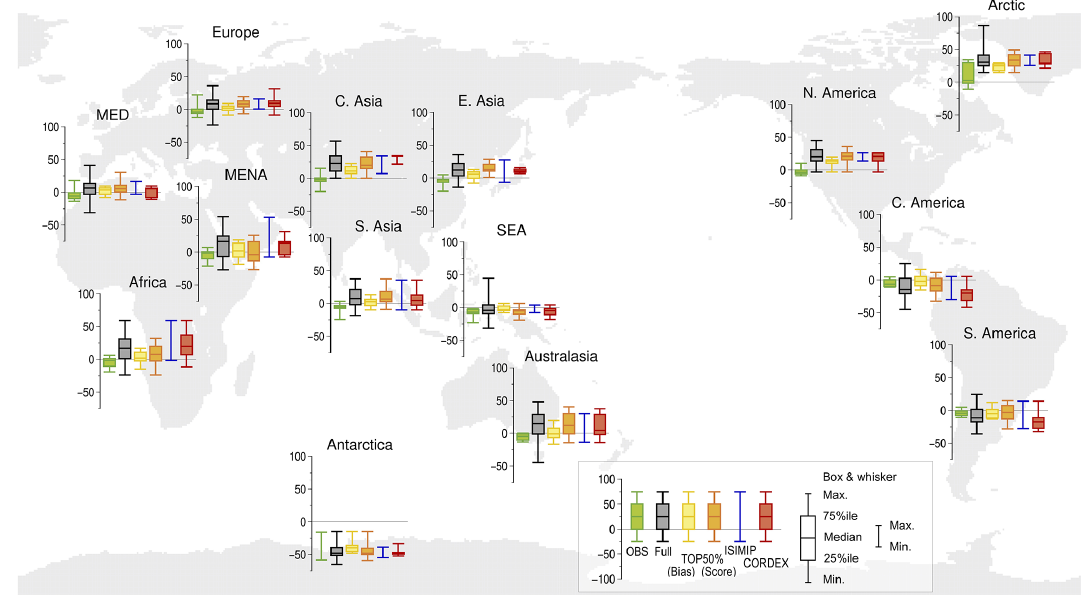
Figure 1. Normalized annual mean model precipitation bias over land from the GPCC reference data (in percent). The bias was normalized by the regional average of GPCC data. The whiskers of the box plots show the range between the maximum and the minimum biases. The boxes and the lines within the boxes indicate the 25th to 75th percentile range and the median respectively. Green plots indicate the deviations of six observation data from the reference data: CRU, GPCC, PRECL, CMAP, GPCP and MSWEP. The other plots indicate the model bias in the full set of 50 CMIP5 model set (black), the model sets with a smaller bias than the median of biases of the full set (yellow), the model sets with higher Taylor’s skill score than the median of the scores of the full set (orange) and the model sets selected for ISIMIP (blue) and CORDEX (red).